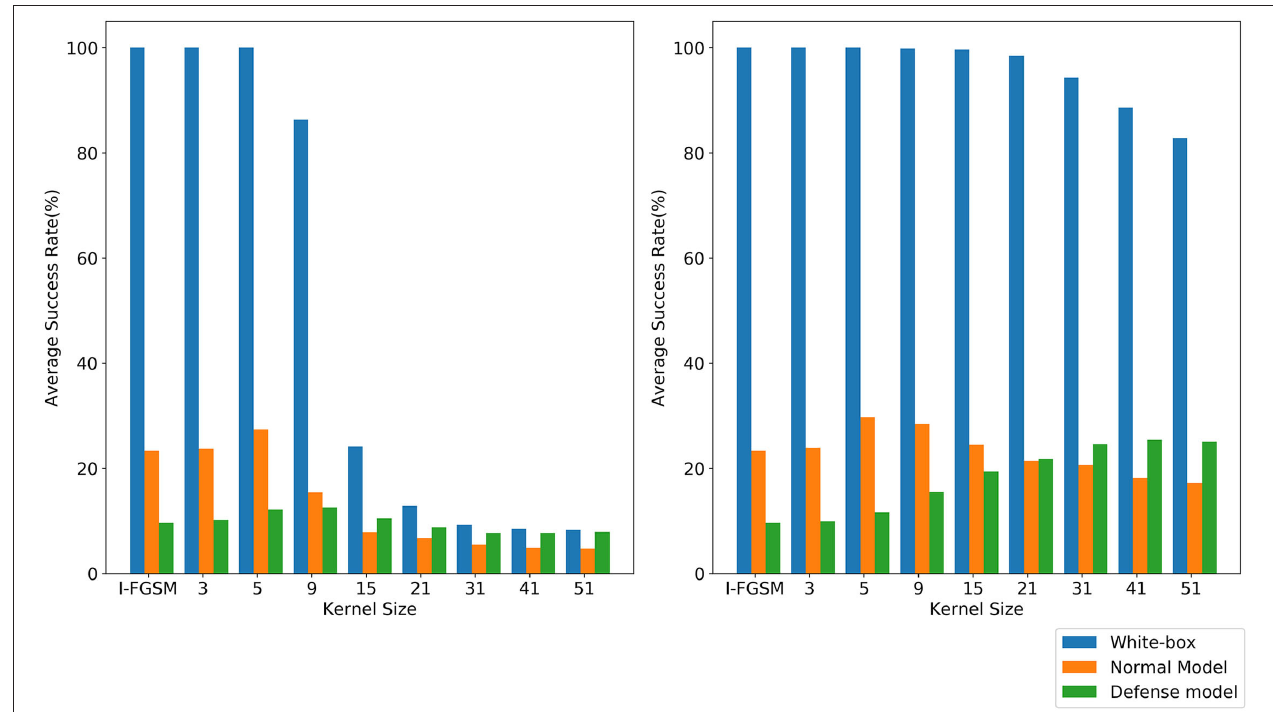
FIGURE 6 | Comparison of GBI-FGSM-F (left) and GBI-FGSM